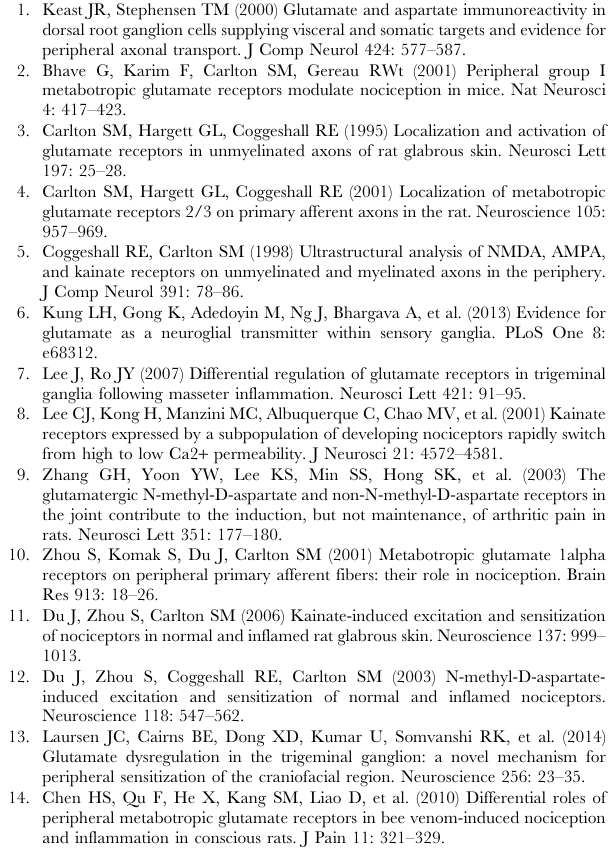
Figure S1 Membrane expression of glutamate receptors. Membrane expression of GluA1 (A), GluA2 (B), mGluR1 (C) and mGluR5 (D) from naı¨ve and CCI DRG normalized to N- cadherin shows trends similar to that analyzed using membrane/ total normalized ratios in the main figures. (TIF) Figure S2 Western blot analysis. Membrane or cytosolic protein fractions (20 m g) were separated by SDS-PAGE and transferred to PVDF membranes. Blots were incubated with antibodies to b - actin (1:7K, upper blot) and N-cadherin (1:1K, lower blot). As expected, b -actin was detected in cytosolic (C1-4) fractions, but not in membrane fractions (M1-4). N-cadherin was detected in membrane (M1-4), but not cytosolic fraction (C, lower blot), thereby confirming that no cross-contamination of cytosolic proteins were present in the membrane fraction and vice versa . N- cadherin and b -actin were used as loading controls to normalize for loading discrepancies. MW: molecular weight marker; KDa: kilo Dalton. (TIF)